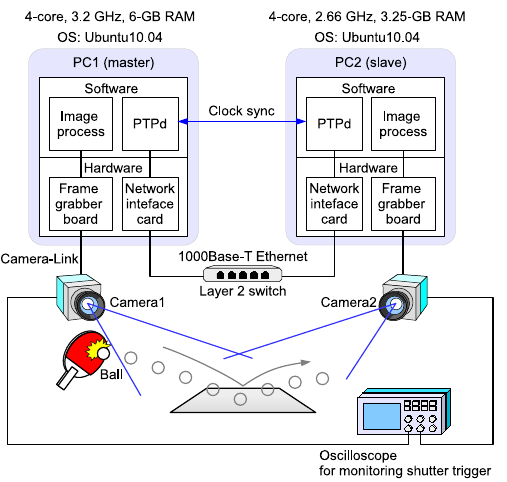
Figure 5. Illustration of experimental system. PC 1 and PC 2 are connected via Ethernet, and the clocks are synchronized by PTP. Cameras 1 and 2 are controlled by PCs 1 and 2, respectively. Shutter control signals fed to the cameras from the PCs are monitored with an